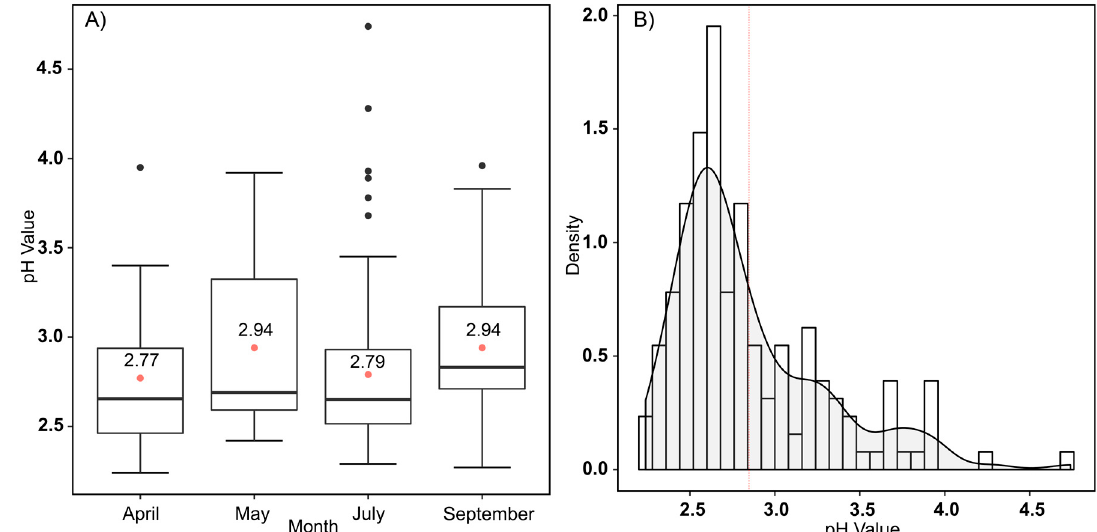
Figure 5. Displayed are the distributions of pH measurements as boxplot and histogram. The boxplots in ( A ) indicate that, for all four campaigns, 50% of the values deviate below 1 pH unit among each other. The red dot in ( A ) marks the mean per month. The histogram ( B ) spreads all measurements, in a bar view and as a density curve. The mean pH for all campaigns is 2.8.